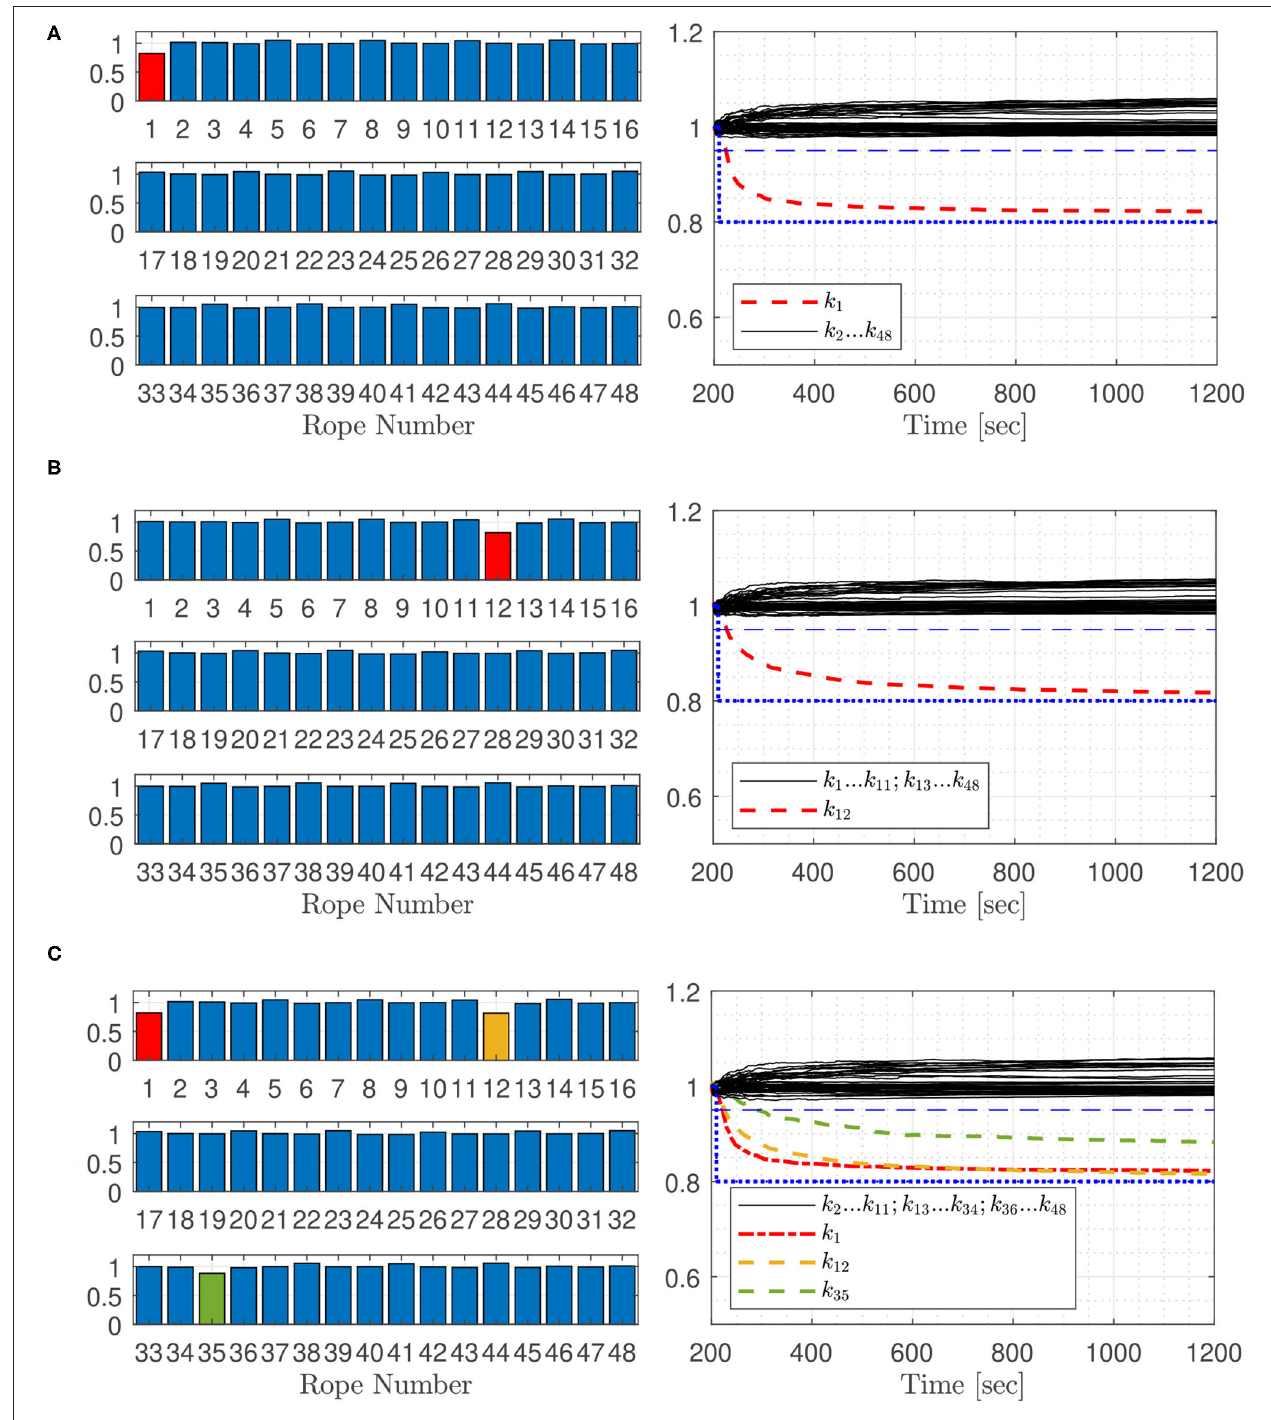
FIGURE 12 | Normalized estimated rope stiffness test cases 6A (A) , 6B (B) , and 6C (C) .